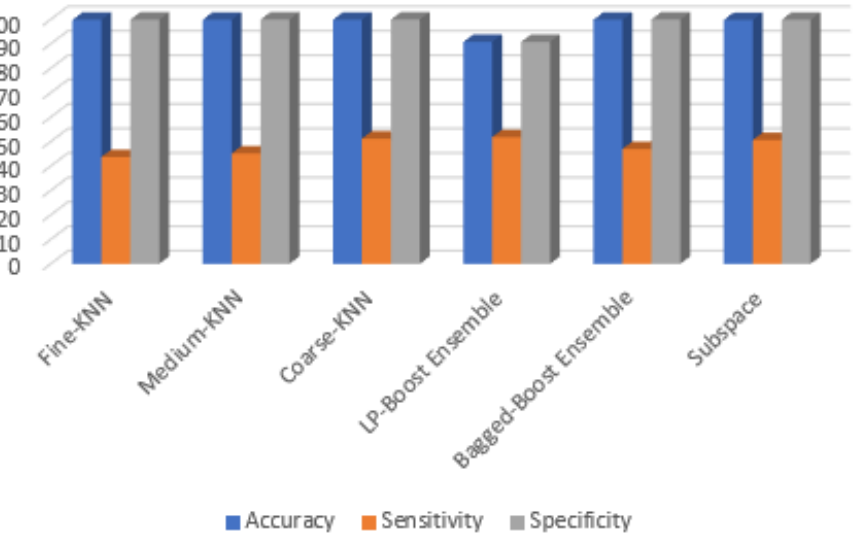
Figure 4. Results of 10-fold predictions using 6 classification methods.